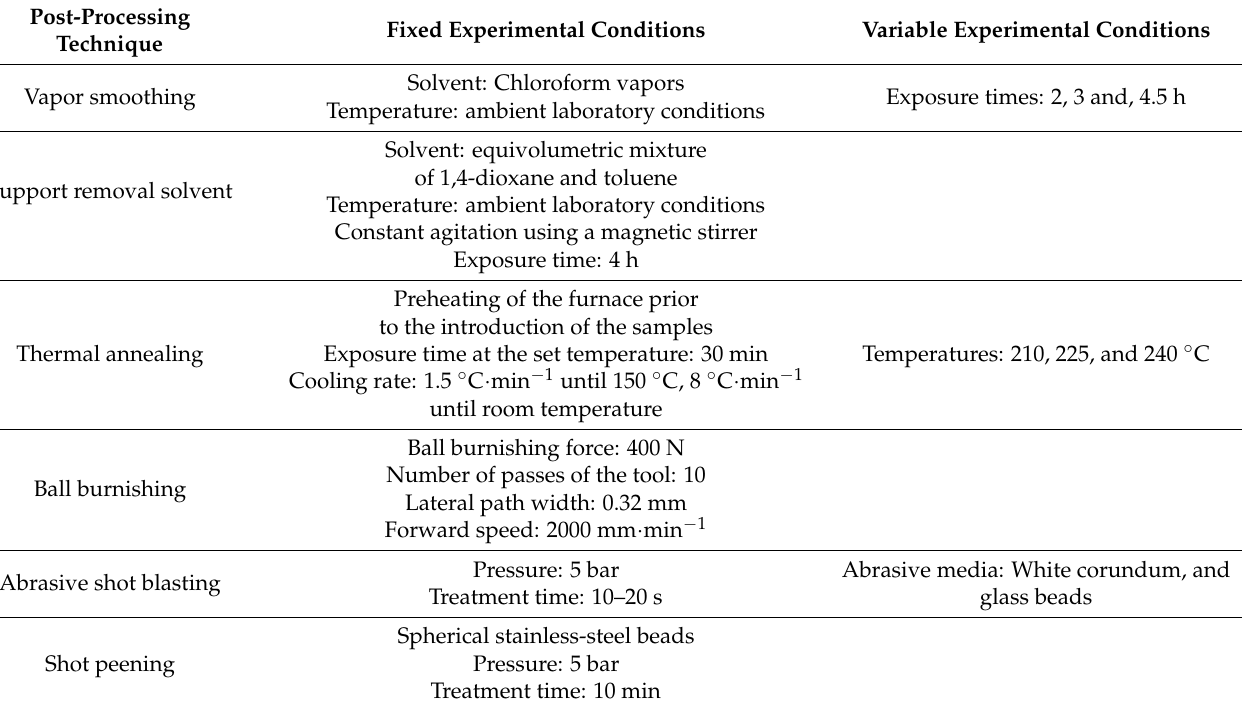
Table 1. Post-processing techniques and procedures applied to Ultem pieces.